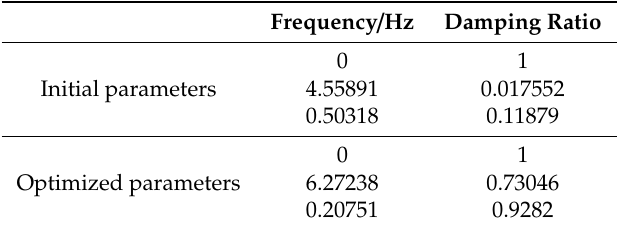
Table 4. Eigenvalues of PV-VSG using initial parameters and optimized